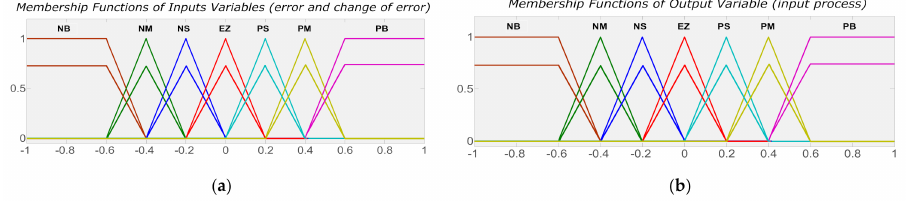
Figure 6. Type-2 fuzzy membership functions (MFs): ( a ) MFs for input variable ‘e’ and ‘de’ of the IT2-FLC; ( b ) MFs for output variable ‘u’ of the